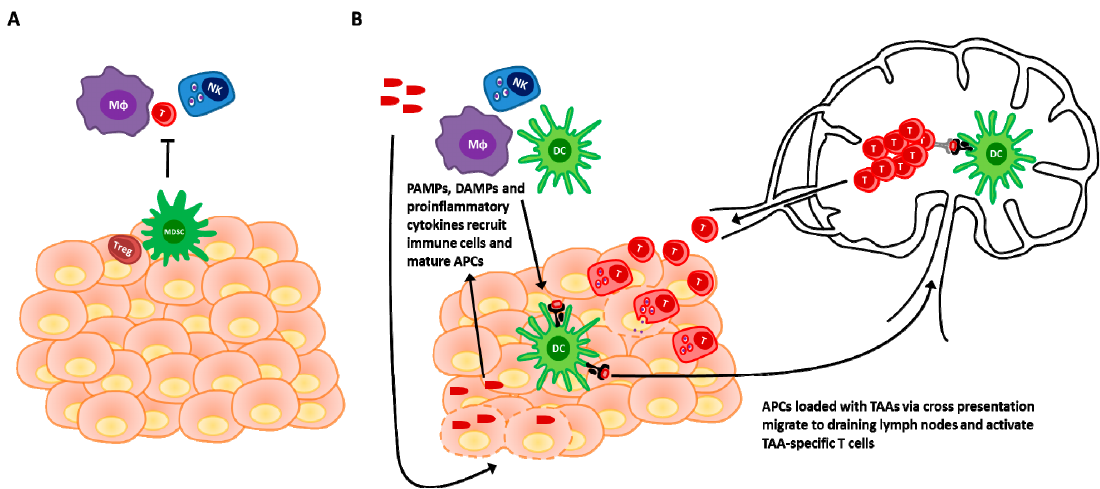
Figure 1. Immunostimulatory actions of oncolytic viruses converts non-inflamed tumors into inflamed tumors and induce an antitumor immune response. ( A ) Established tumors with a non-inflamed phenotype show a reduced inflammatory cytokine expression profile and a lack of T cell infiltration. A state of immune exclusion and ignorance is induced in these tumors by immunosuppression induced by inhibitory immune cells such as Treg and myeloid derived suppressor cells (MDSC) in the tumor microenvironment; ( B ) Infection of a tumor with an oncolytic virus leads to a variety of immunostimulatory actions which can convert a non-inflamed tumor into an inflamed tumor and promote an antitumor response. OV infection leads to the release of chemokines and cytokines from infected cells which recruit a variety of innate and adaptive immune effector cells. PAMPs (pathogen associated molecular patterns) associated with OVs and DAMPs (danger associated molecular patterns) released upon oncolysis provide maturation signals to antigen presenting cells within the tumor microenvironment which then phagocytose and cross-present these antigens in the secondary lymphoid organs to induce an adaptive anti-tumor response.